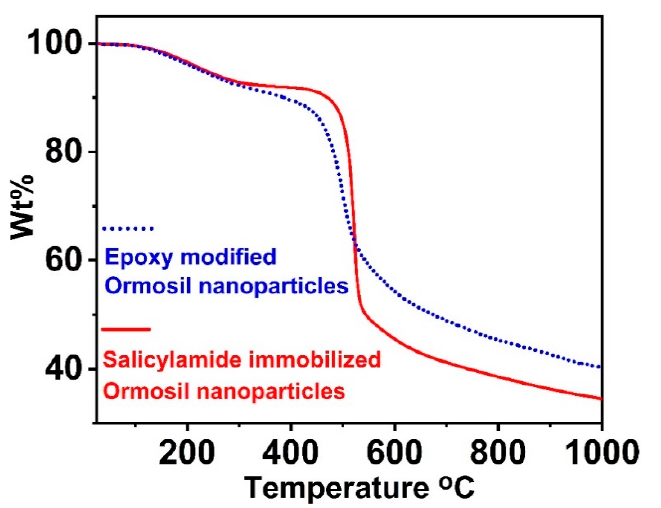
Figure 3. TGA of the salicylamide-immobilized ormosil nanoparticles before (blue) and after (red) immobilization.